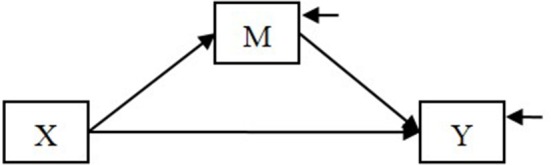
A mediation model.